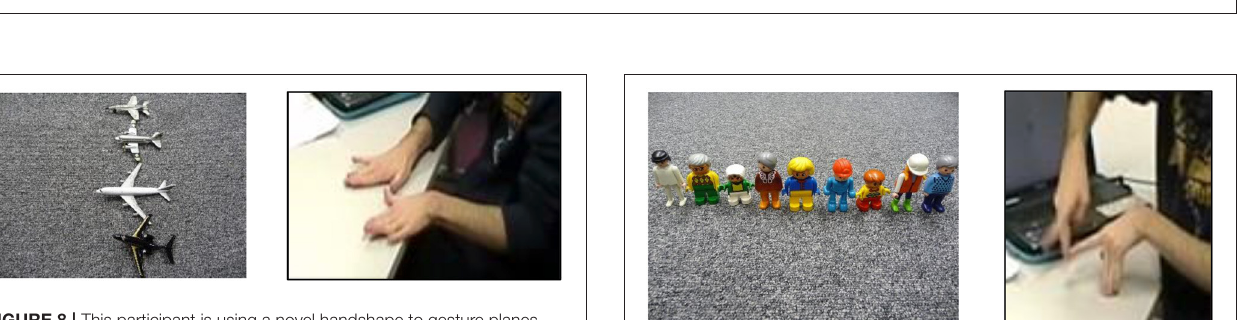
FIGURE 7 | The overlapping entity classifier handshape inventories of sign-naïve gesturers, learners of BSL, and native signers. Numbers represent the number of handshapes at the intersections of the different inventories (e.g., 12 is the number of handshapes that occurs in the inventories of all three participant groups: native signers, learners of BSL and sign-naïve gesturers).